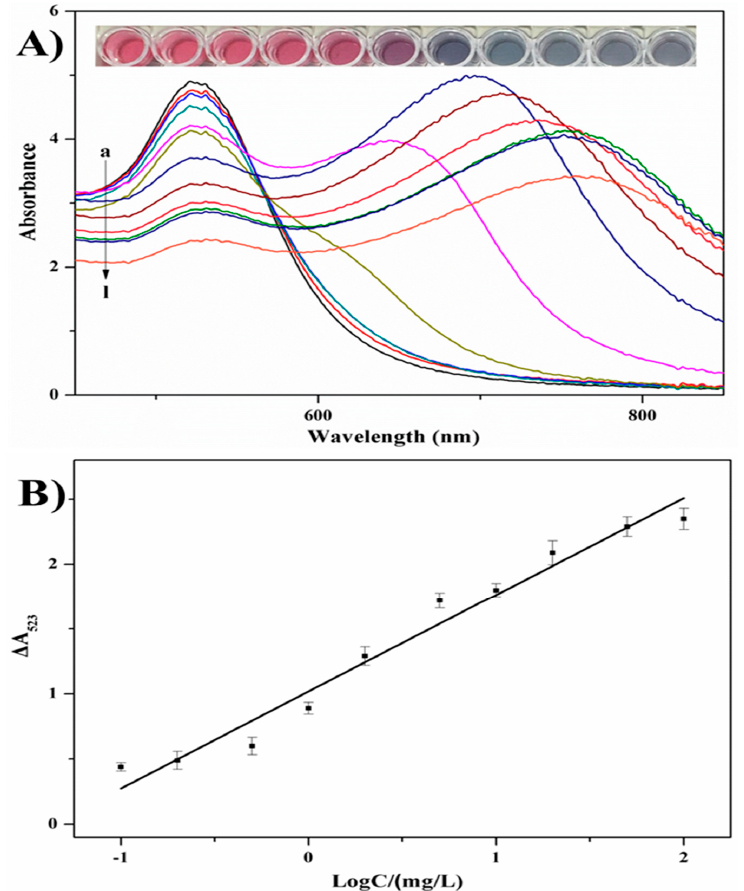
Figure 6. ( A ) UV-Vis spectra and a photograph of (a) AuNP solutions, AuNP solutions with concentrations of chlorsulfuron of (b) 100 mg/L , (c) 50 mg/L, (d) 20 mg/L, (e) 10 mg/L, (f) 5.0 mg/L, (g) 2.0 mg/L, (h) 1.0 mg/L, (i) 0.5 mg/L, (j) 0.2 mg/L, (k) 0.1 mg/L (l) 0 mg/L in the presence of 20 mg/L